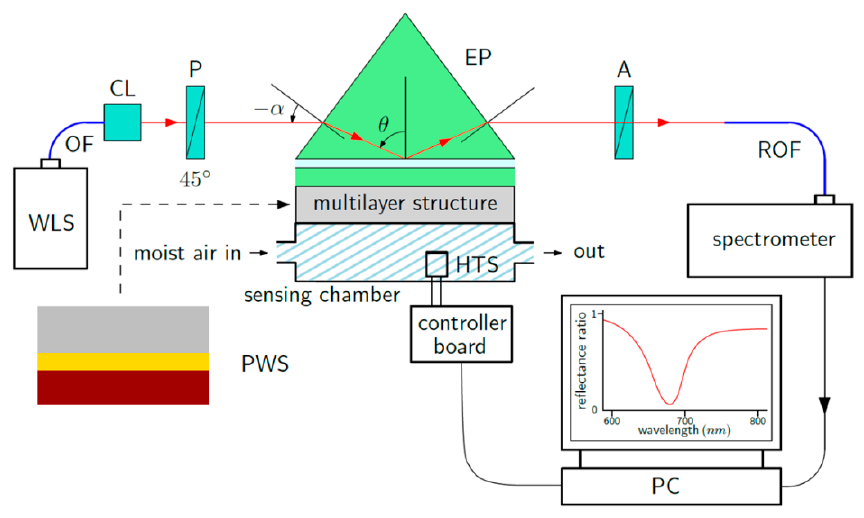
Figure 7. Scheme for the experimental setup.